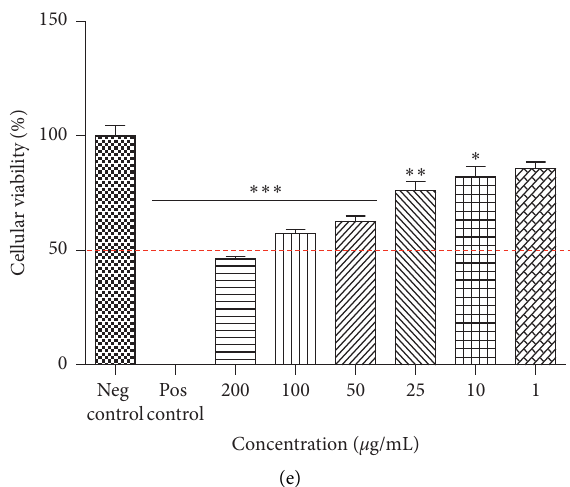
Figure 4: Evaluation of enzymatic production of Burkholderia cepacia COPS in solid media: (a) protease; (b) esterase; (c) lipase. Activity of B. cepacia COPS NPE at different concentrations against promastigotes of L. infantum (d) and L. major (e) after 24 hours of exposure. Values represent two independent experiments performed in triplicate. ∗∗∗ Indicates statistical significance compared to the negative control, with values of p < 0 .